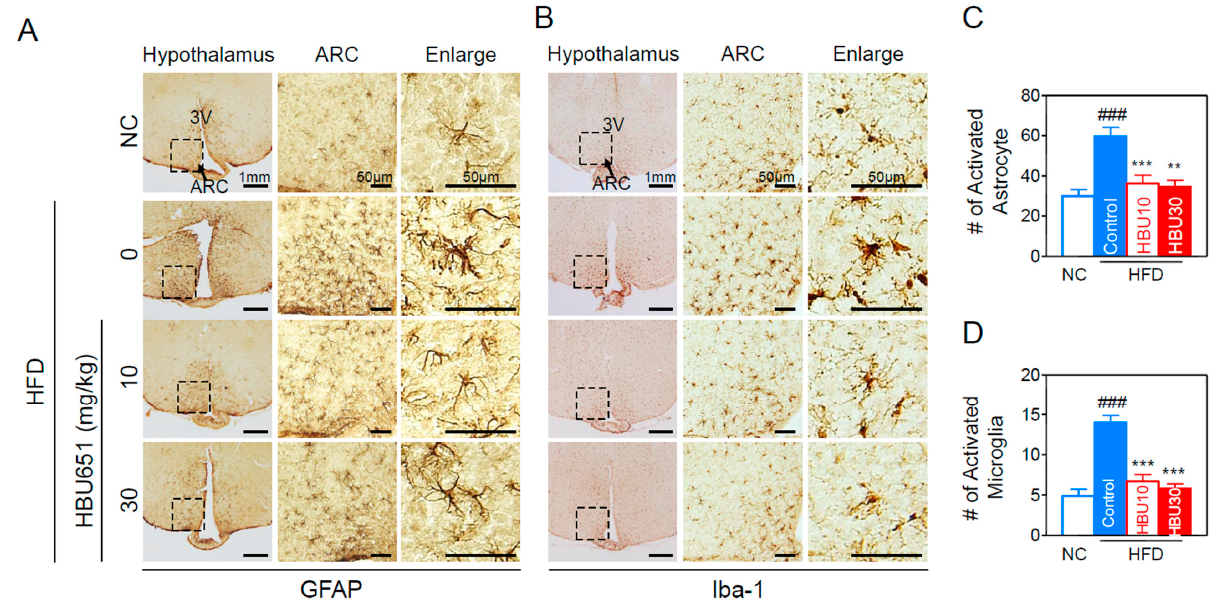
Figure 8. HBU651 attenuates HFD-induced hypothalamic inflammation. ( A , B ) Representative images and higher magnification inset of the hypothalamus of HFD-fed mice. Hypothalamic sections were immunostained with GFAP ( A ) or Iba-1 ( B ) antibodies. The arcuate nucleus (ARC) area (arrow, inset box) and the third ventricle (3V) are indicated. Box area in ARC has been enlarged to view the cellular morphology. ( C , D ) Quantification of astrocytes (GFAP-positive cells) ( C ) and activated microglia (Iba-1 positive cells) ( D ) in the ARC. Data are expressed as means ±SEM ( n = 5). ### p < 0.001 vs. NC, and ** p < 0.01. *** p < 0.001 vs. HFD-control. NC, normal chow; Control, HFD-control; HBU10, HFD plus HBU651 10 mg/kg; HBU30, HFD plus HBU651 30 mg/kg.